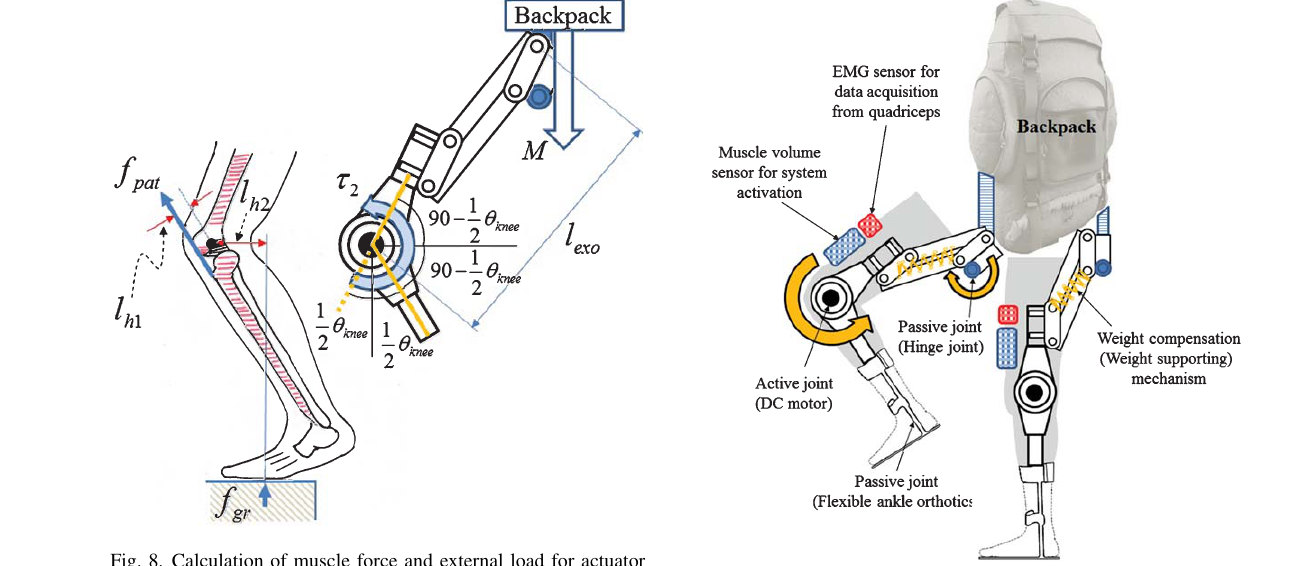
Fig. 9. Experimental setup of the proposed exoskeleton